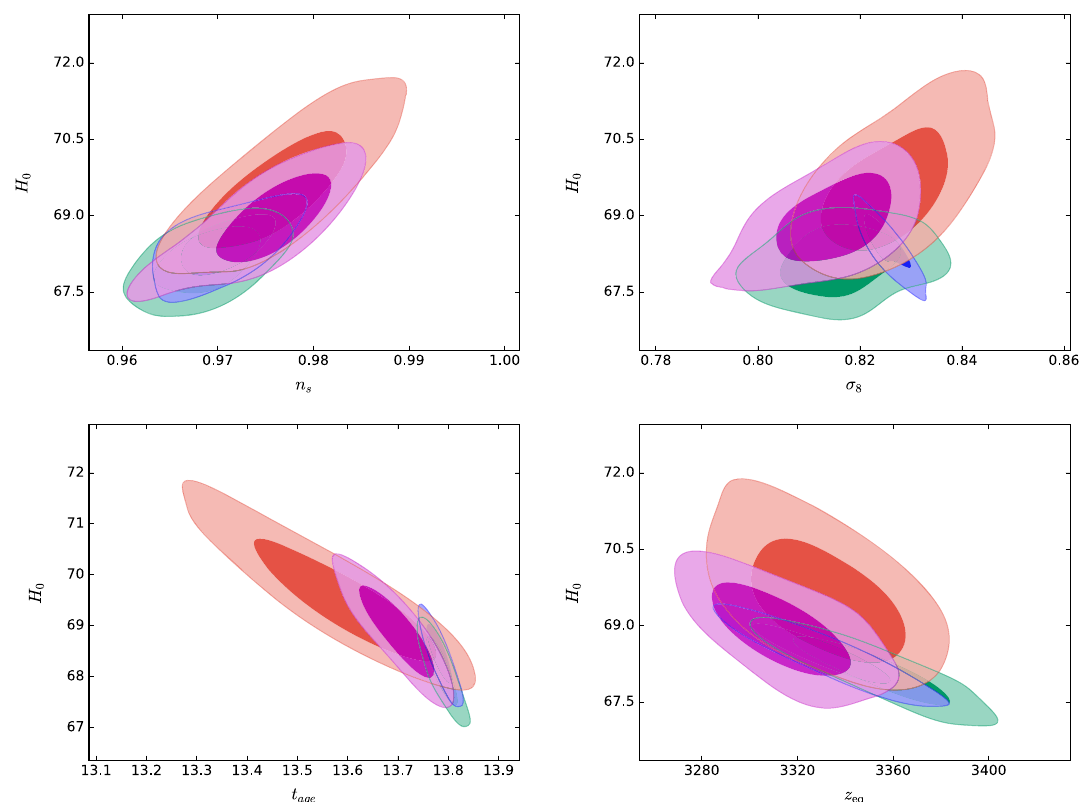
Fig. 8 The 2-dimensional marginalized contours of the (cid:5) CDM (green), F (cid:5) (blue), Fs (red) and Fms (magenta) models in the planes of n s − H 0 , ω − H − H − H m 0 , t age 0 and z eq 0 by using the data combination CBSLCH,